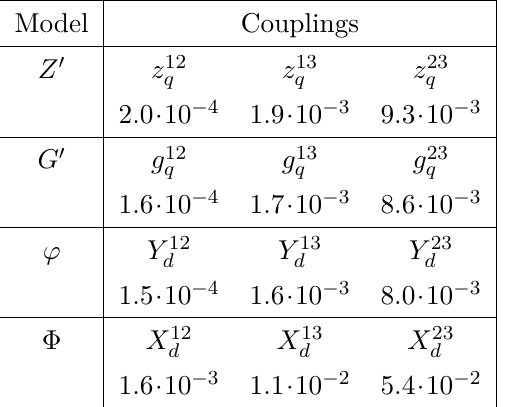
Table 8 . The values of flavour-violating couplings for M Z 0 ,G 0 ,ϕ, Φ = 5 TeV that give rise to 20% NP corrections to 2